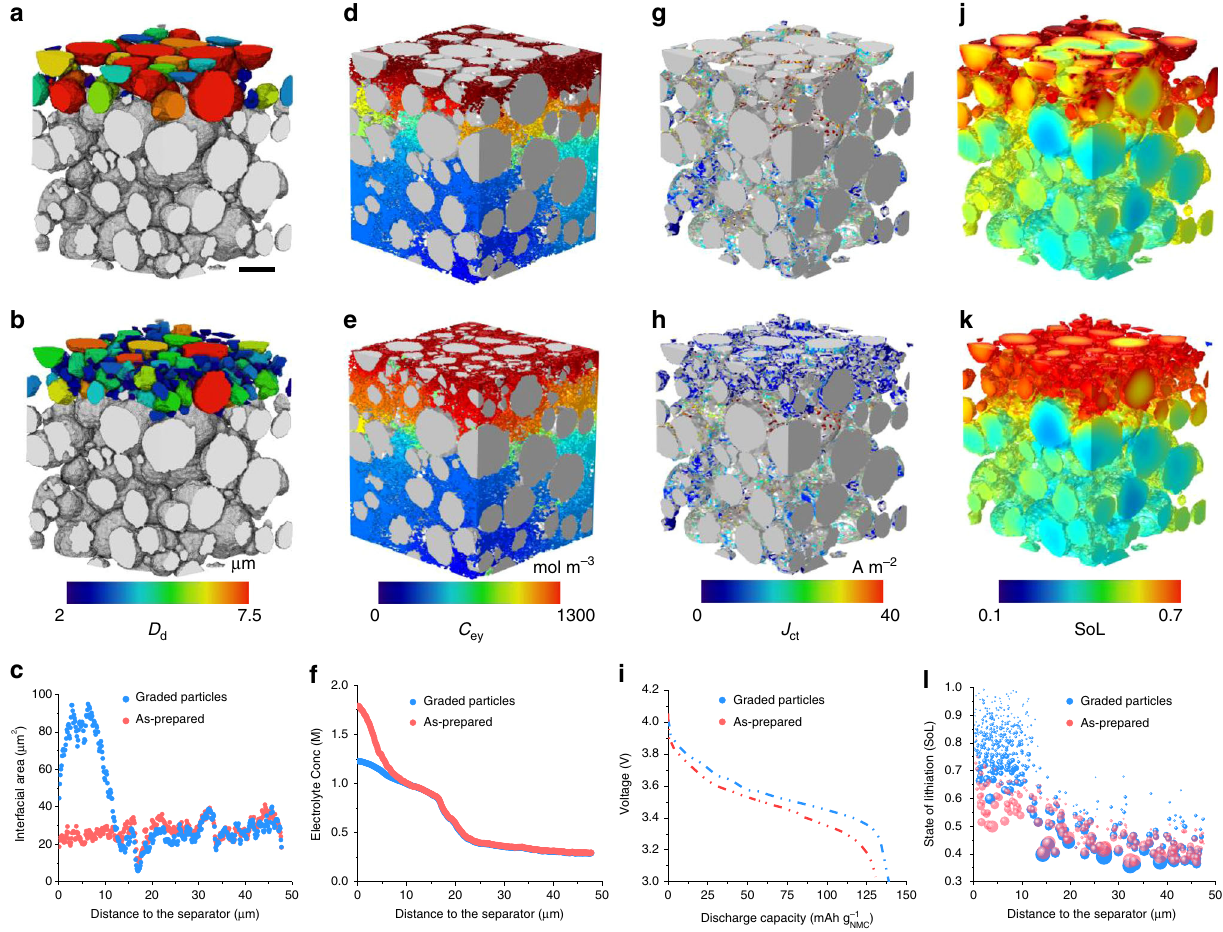
Fig. 6 Comparison between the as-prepared (top row) and graded-particle (middle row) samples at 50% DoD and 3.75 C discharge. a , b Comparison of the particle size distribution; c change in interfacial reaction area as a function of the depth in the electrode; d − f comparison of the distribution of the electrolyte concentration; g , h distribution of charge transfer current density and i the resultant voltage vs. capacity curve; j − l comparisons of the SoL. The scale bar in ( a ) represents 10 μ